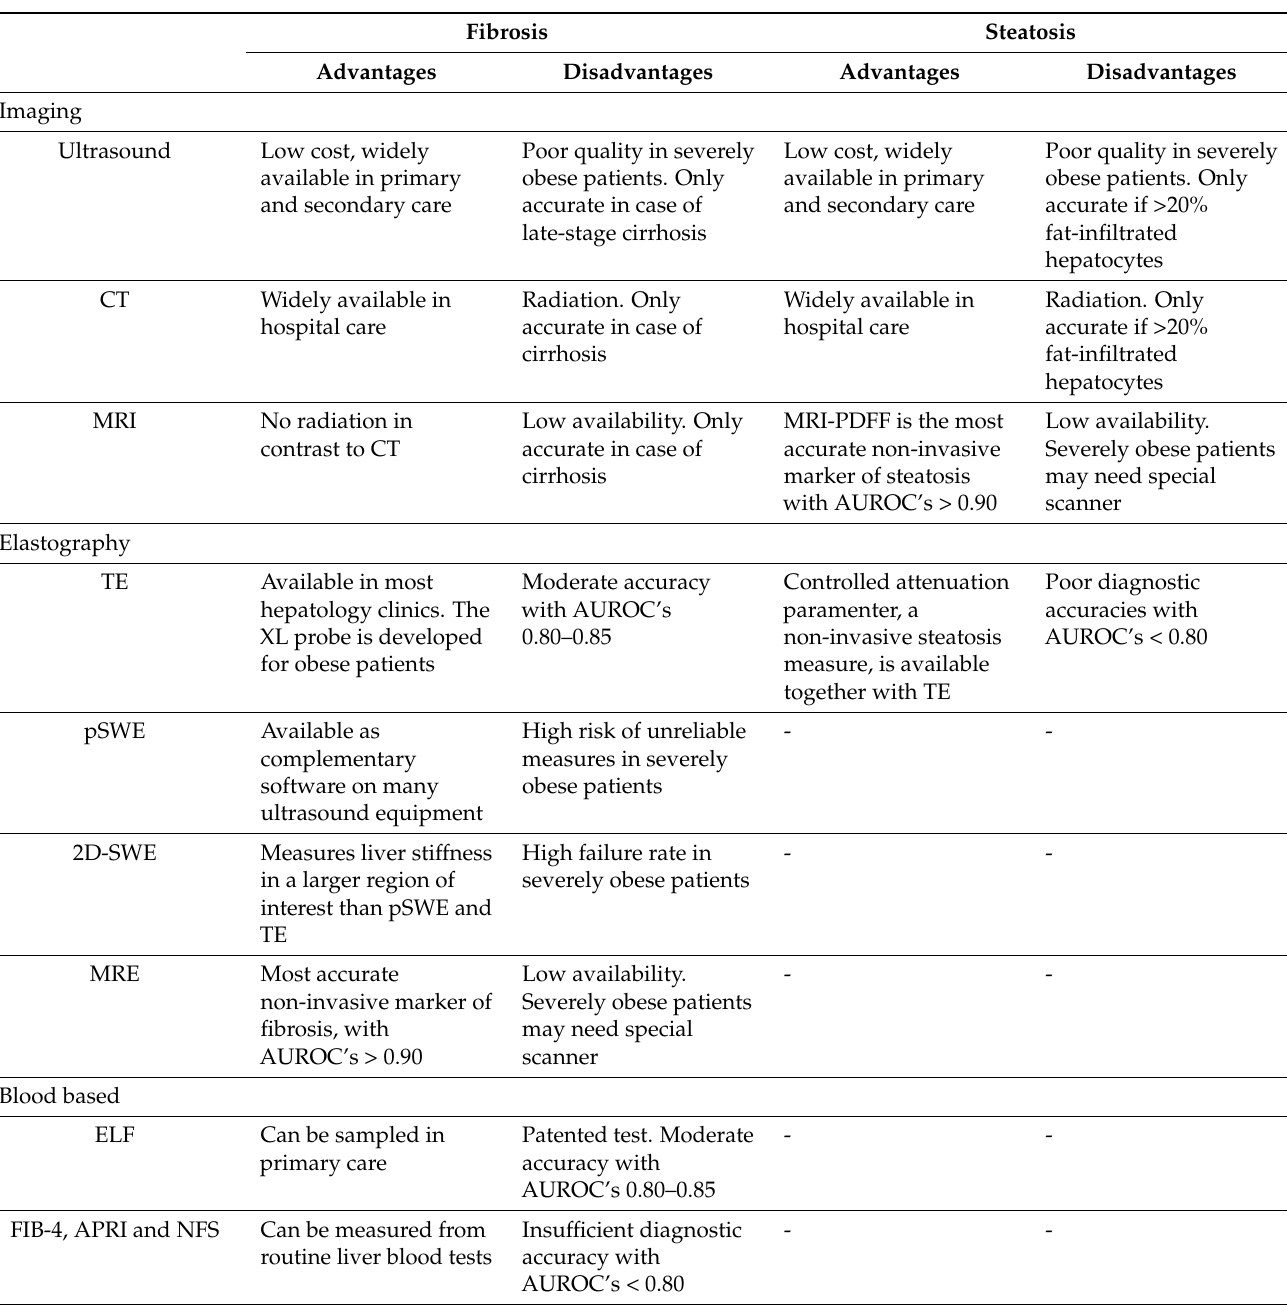
Table 2. Advantages and disadvantages of diagnostic markers for the assessment of steatosis and advanced fibrosis in severely obese patient with non-alcoholic fatty liver disease